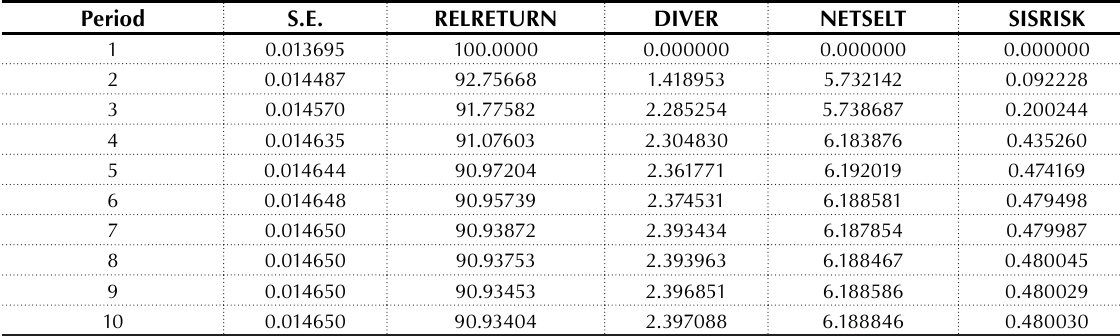
Table 3. Variance decomposition of